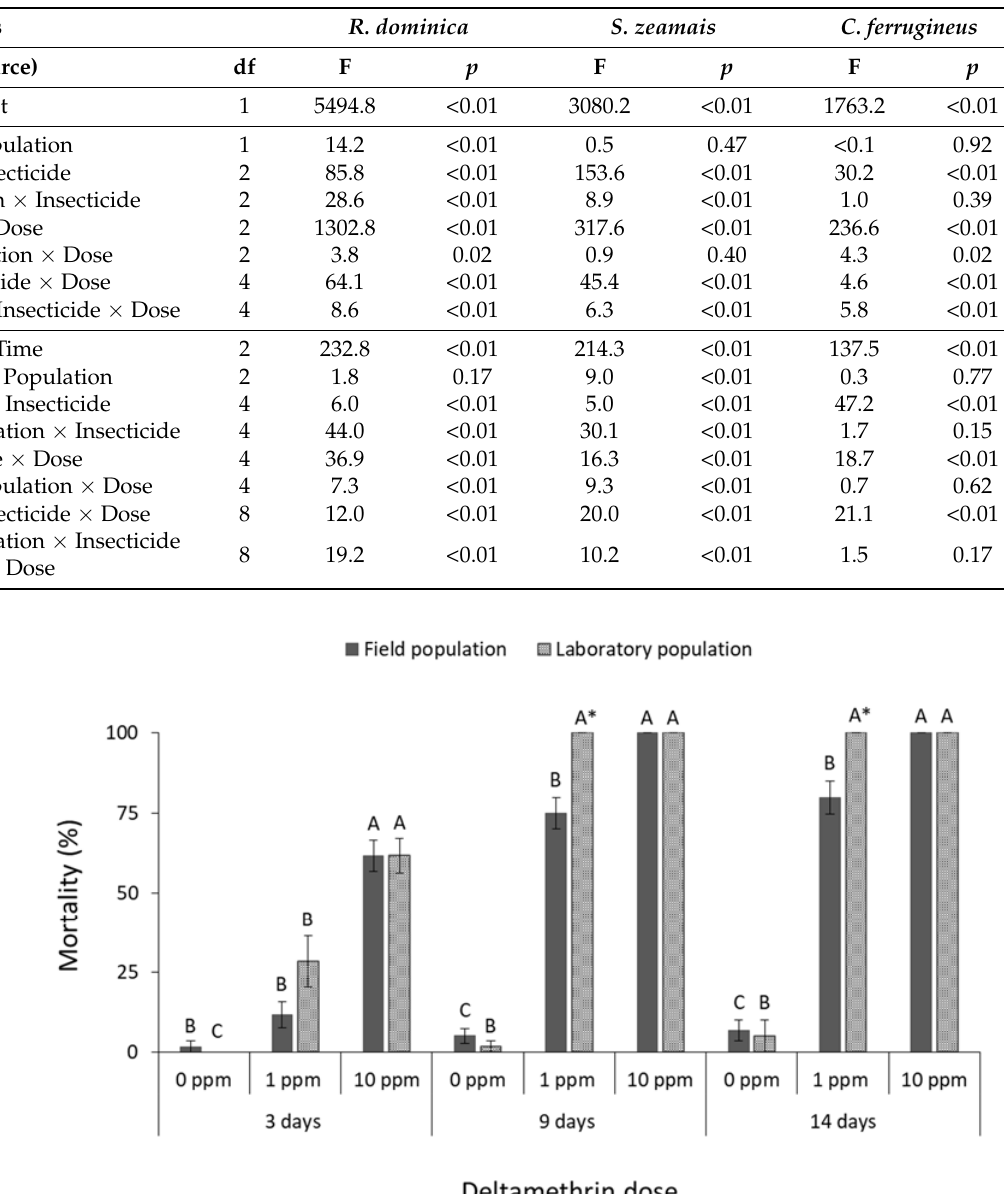
Table 1. MANOVA parameters for mortality levels of R. dominica , S. zeamais and C. ferrugineus adults between or within variables (Repeated Measures ANOVA, df = 108).